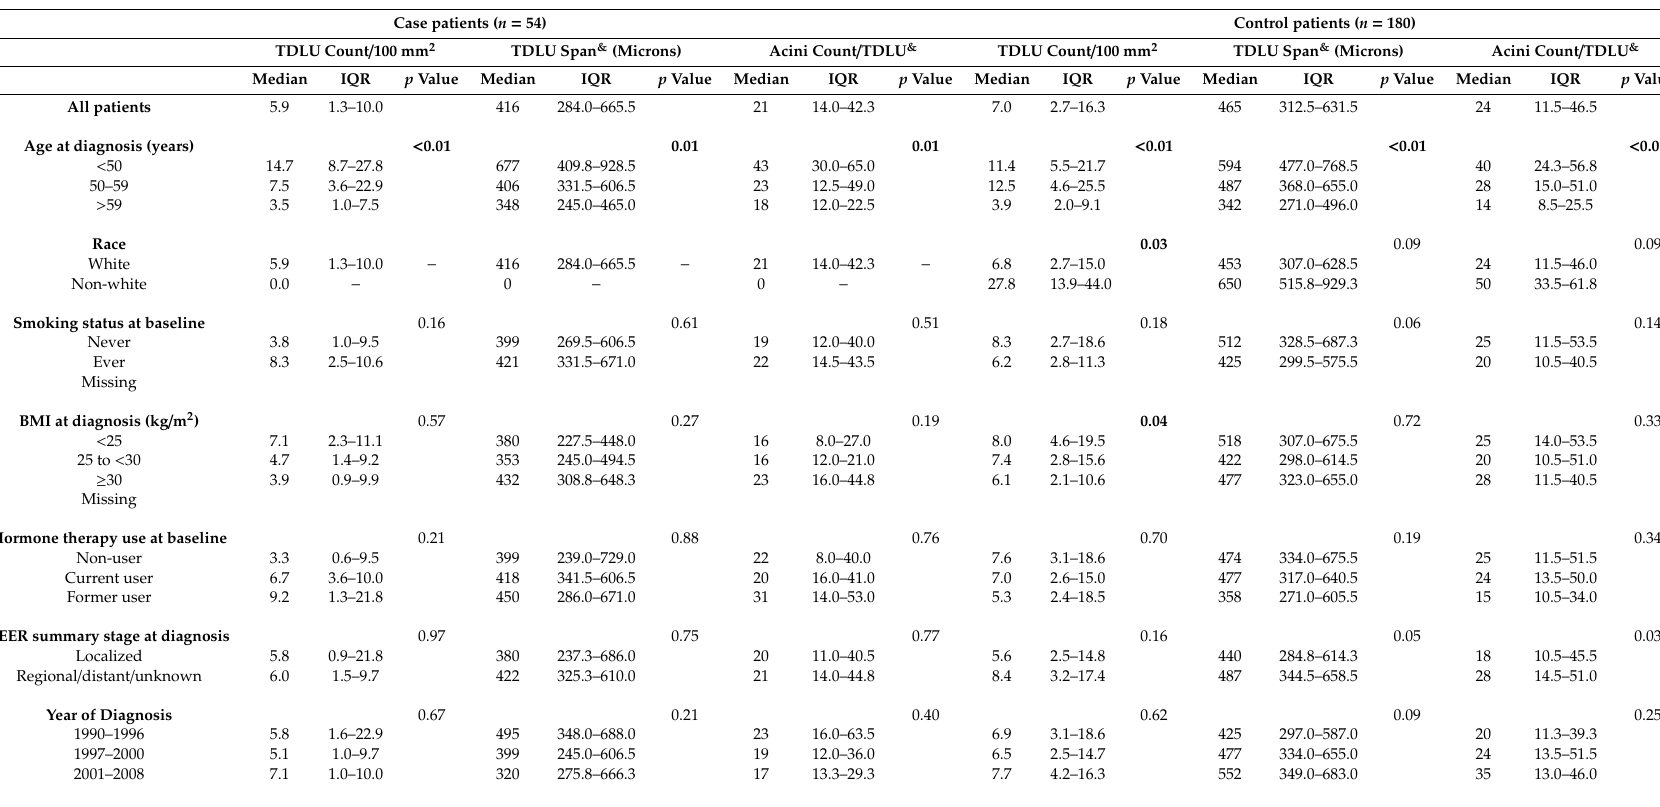
Table 2. Relationship between patient and tumor characteristics and TDLU measurements among ER-positive case and control breast cancer patients treated with